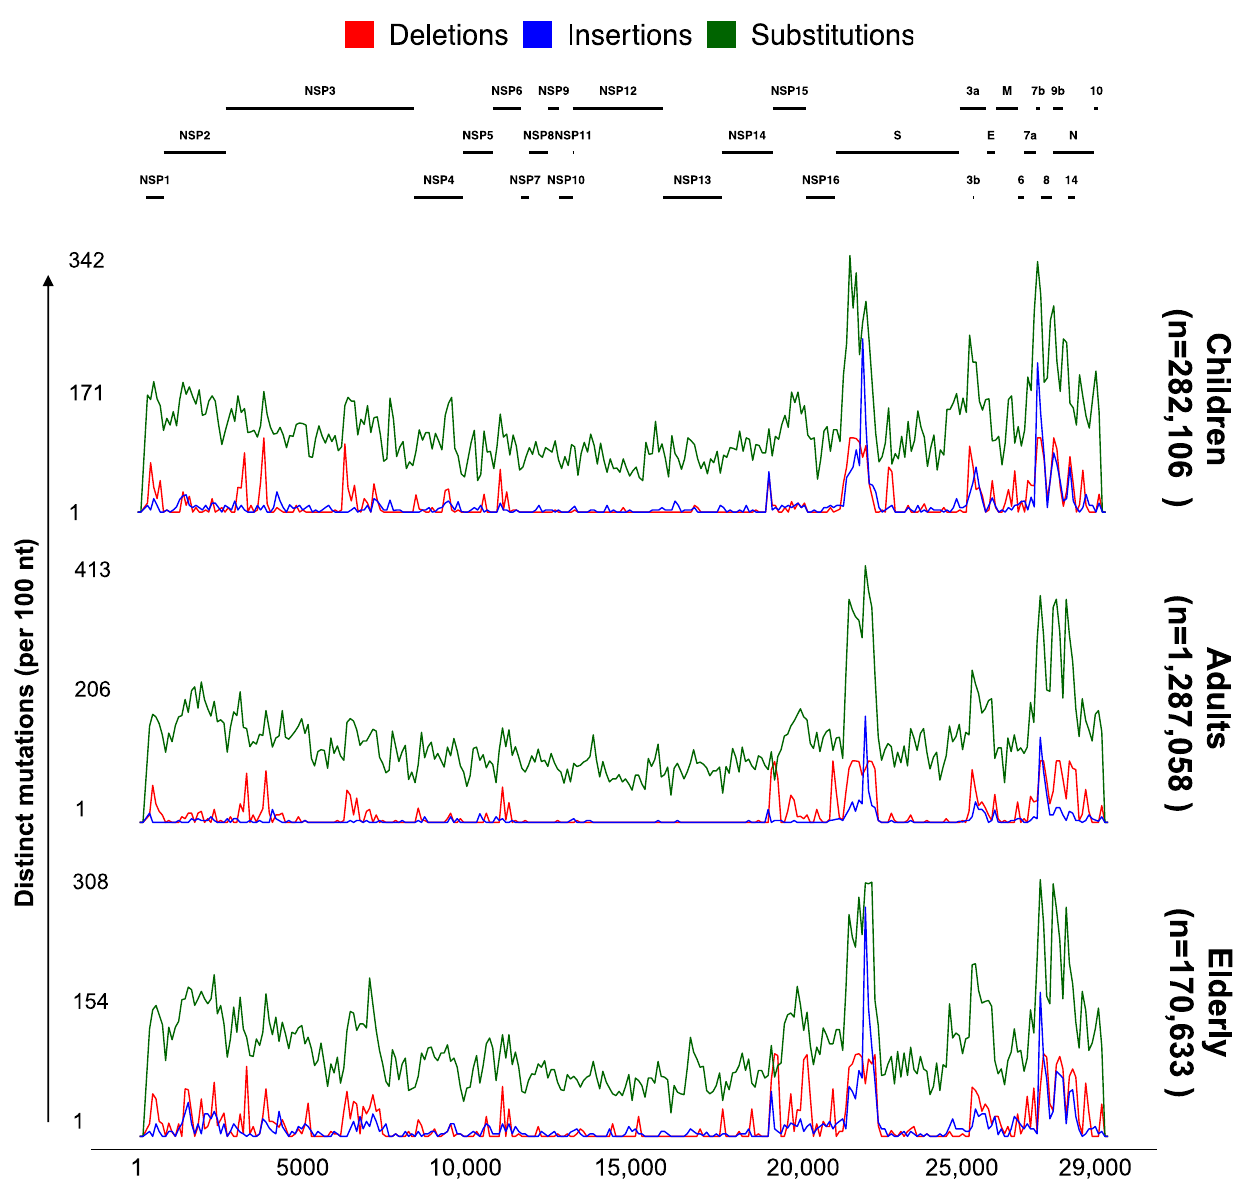
Figure 6. Genomic distribution of SARS-CoV-2 mutations for three age groups. Each plot depicts the number of distinct protein mutations in a 100 nucleotide sliding window across the SARS-CoV-2 genome in specimens collected between January 2020 and May 2022 in the USA (n = 1,739,797 sequences from GISAID as of 31 May 2022). Sequences were divided into six groups based on the age of patients (children (up to 18 years), adults (18–64 years), and elderly (65 years or more)). The total number of sequences used per age group is indicated. Each subset of genomes was processed separately using the ViralVar “Lineage Dynamics”